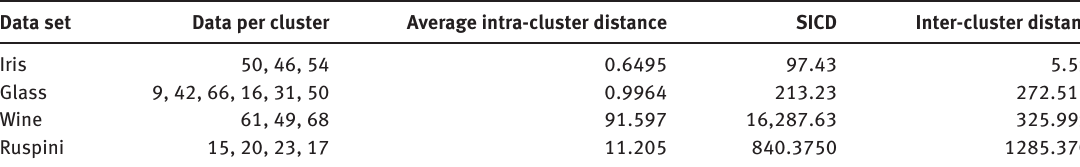
Table 5: SSO Cluster Distribution.